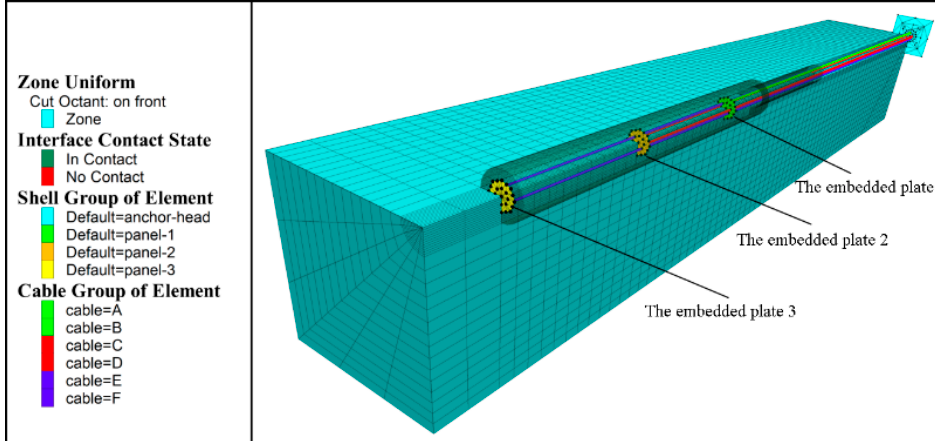
Figure 4. Quarter grid model.